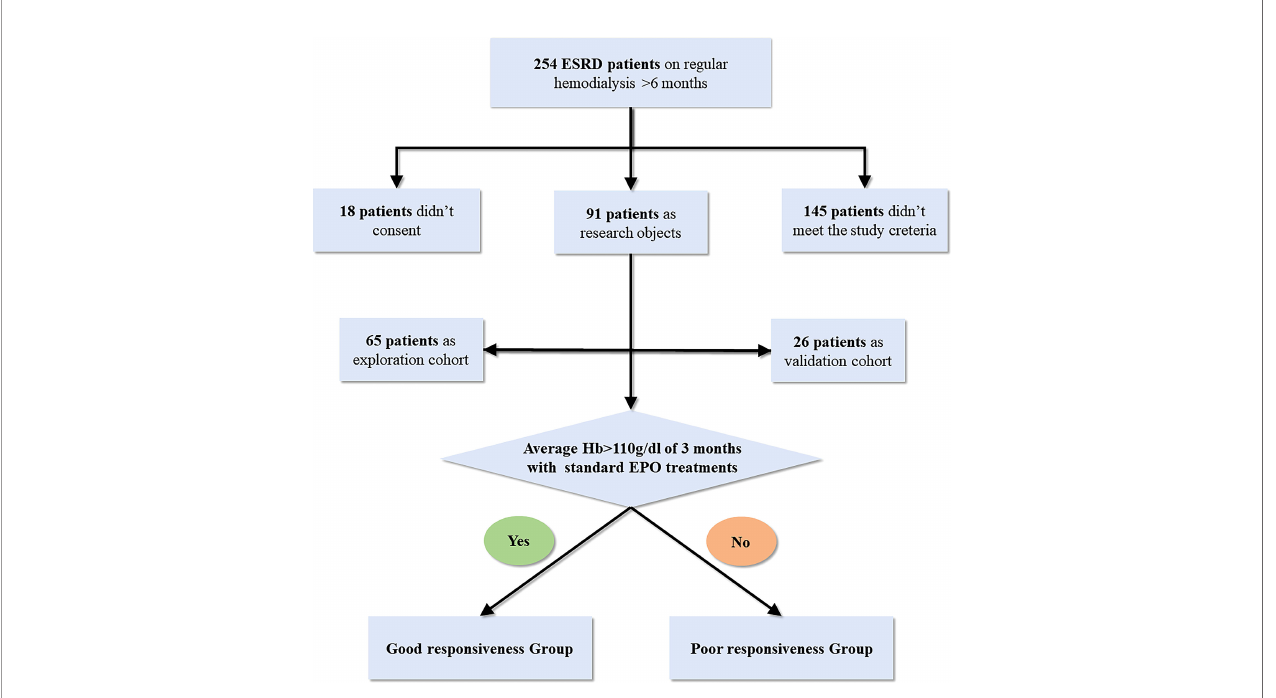
FIGURE 1 | Flowchart of this